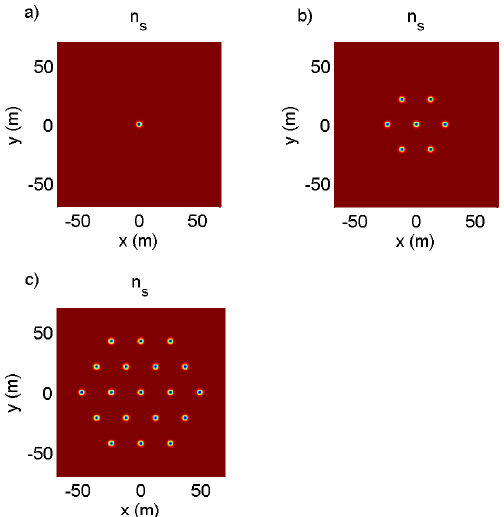
Figure 4. Simulations using a deep striation with α = 0 . 1, exclud- ing collisions (top) and including collisions with ν e = 10 3 s − 1 (bot- tom), showing the electromagnetic (EM) field amplitude associated with Z -mode waves (panels a and c ) and electrostatic (ES) am- plitude associated with UH waves (panels b and d ). The driving frequency ω 0 is set equal to resonant frequency 21 . 127 × 10 6 s − 1 corresponding to the lowest radial mode for N = − 1 and R = 1 in Fig. 1b. The dashed lines in panels (b) and (d) show the result of electrostatic simulations.